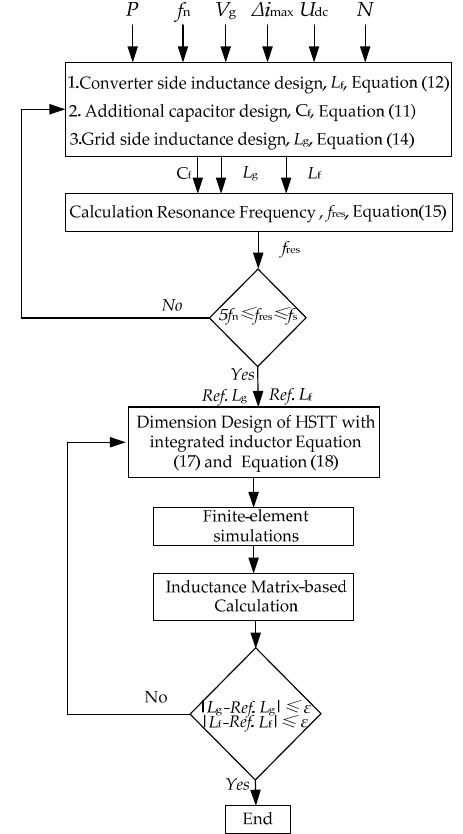
Figure 7. Flowchart of design and calculation procedure of the proposed HSTT with IFIs.